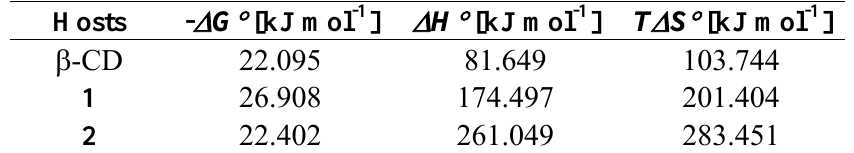
Table 2. Thermodynamic parameters for the inclusion complexation of 3 with β -CD, 1 and 2 in the aqueous phosphate buffer solution (pH 7.4) at 25 °C.